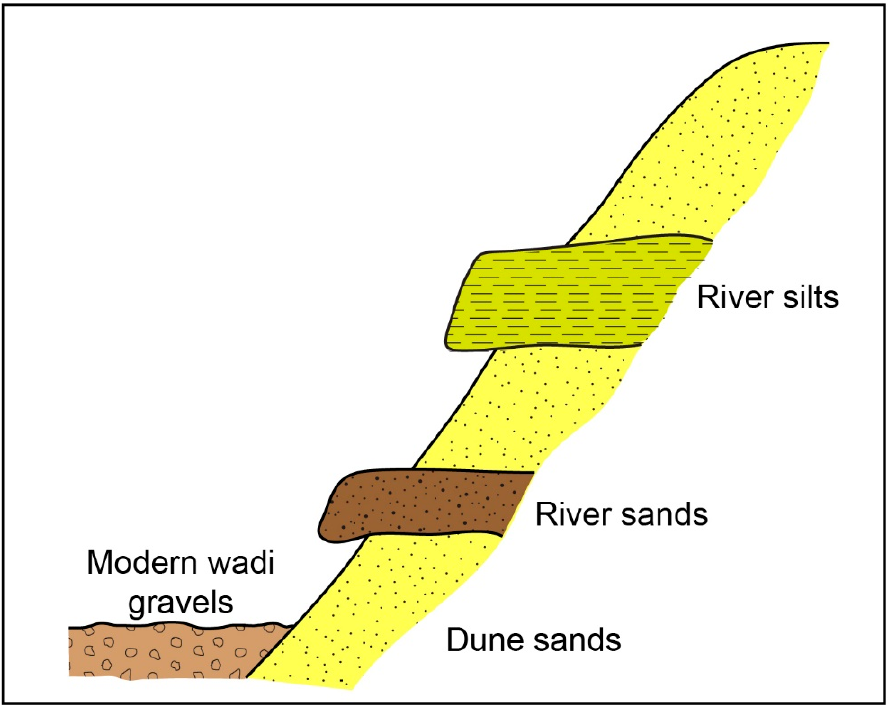
Figure 2. Alternating wind-blown sands and river and lake sediments, indicating alternating wetter and drier climatic conditions. Based on the author’s observations in the south-central Sahara.